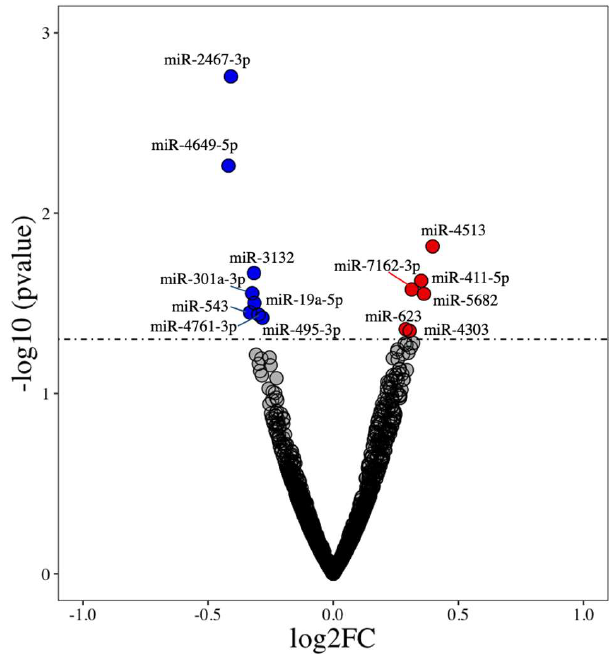
Figure 1. Differentially expressed miRNAs between human subjects during the pre- and post-TRE regimen. Highlighted are the names of differentially expressed miRNAs with p < 0.05. Upregulated miRNAs are represented on the upper right quadrant (red dots) and downregulated miRNAs on the upper left quadrant (blue dots). Table 2. Associated biological pathways with miRNA targets: KEGG